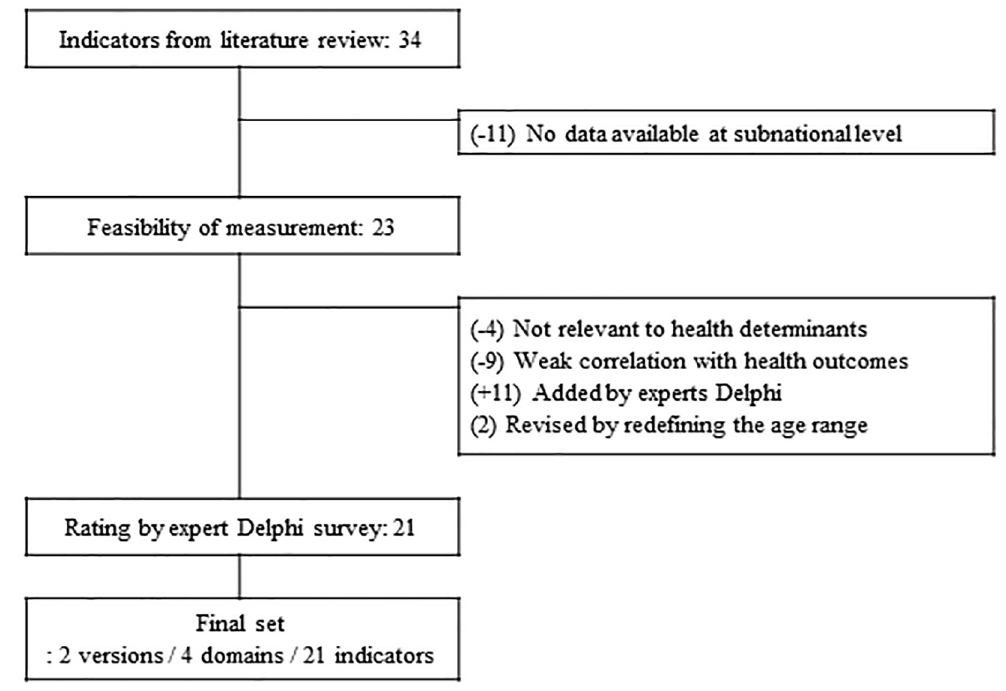
Fig 1. Process for the selection of K-CHDI